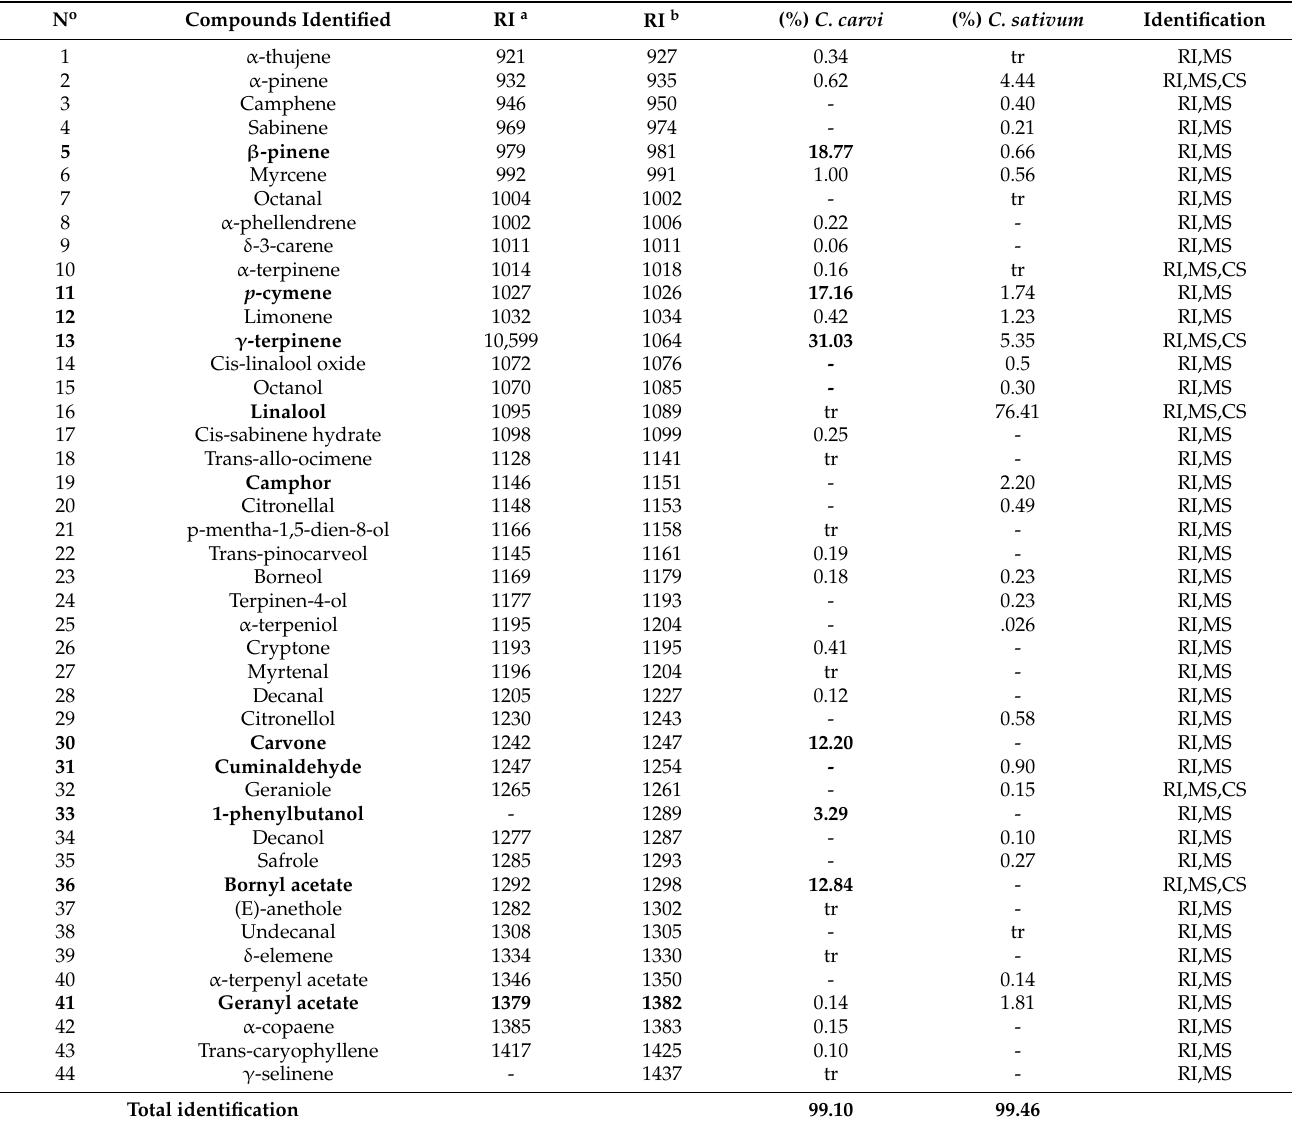
Table 1. Chemical composition (%) of the EOs isolated from the seeds of two Tunisian spices C. carvi and C. sativum . N